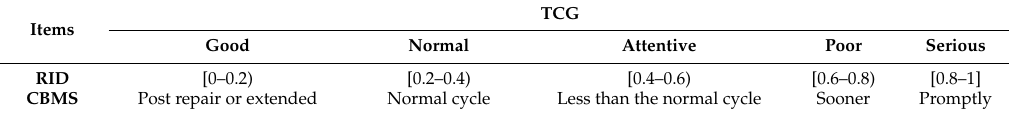
Table 1. Relationships between relative deterioration degrees, condition grades and maintenance